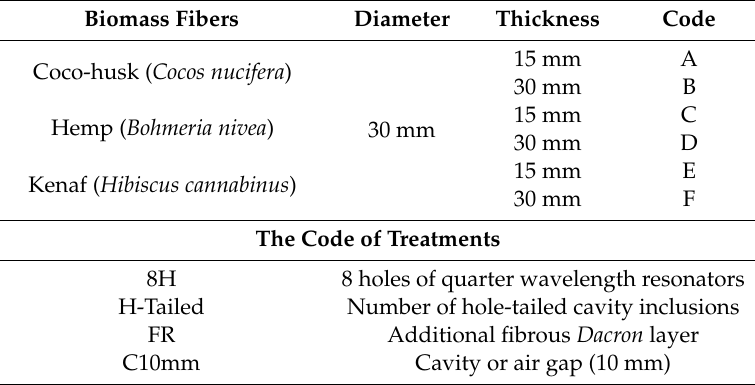
Table 1. The three kinds of biomass fiber specimens under observation.